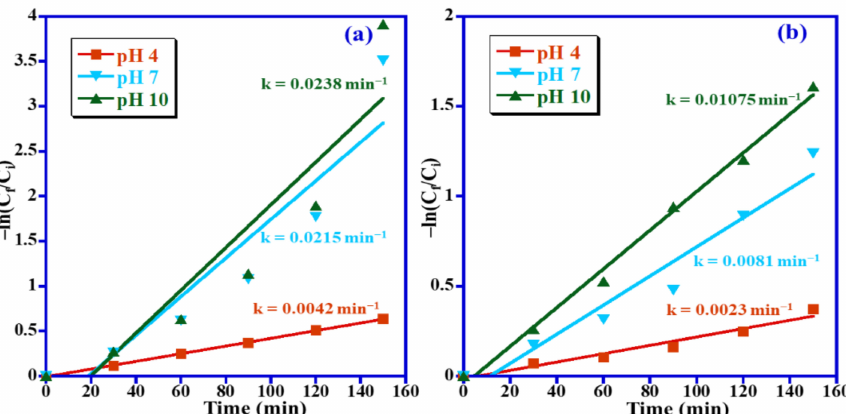
Figure 12. Psuedo first-order kinetics for photocatalytic removal of ( a ) MB and ( b ) MO over Mn 3 O 4 /ZnO/Eu 2 O 3 photocatalyst.